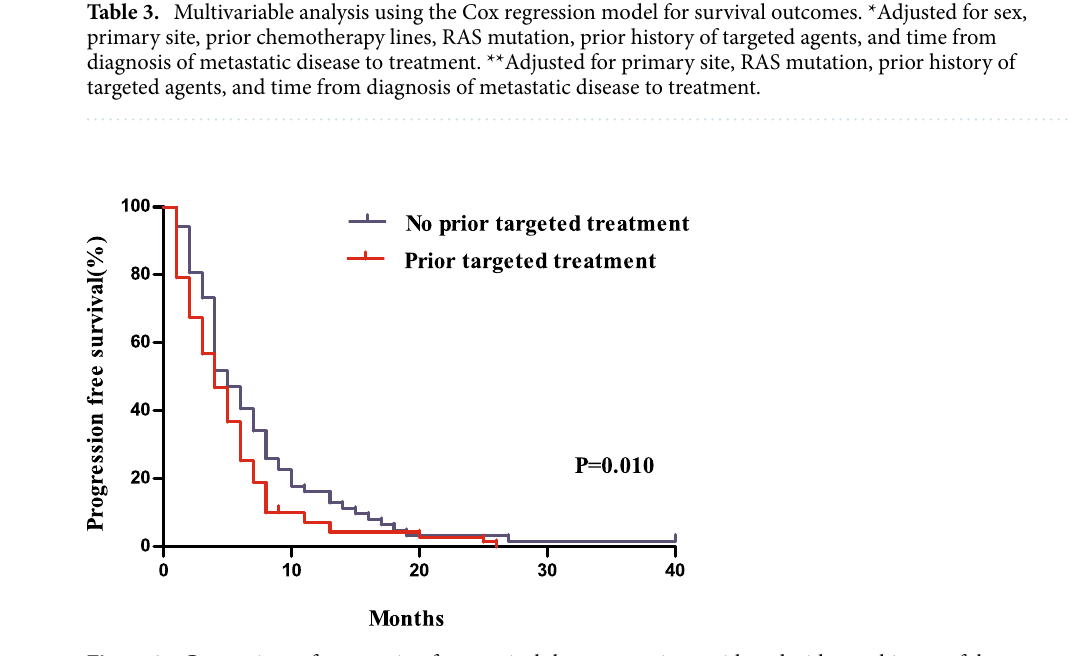
Figure 3. Comparison of progression free survivals between patients with and without a history of the administration of targeted